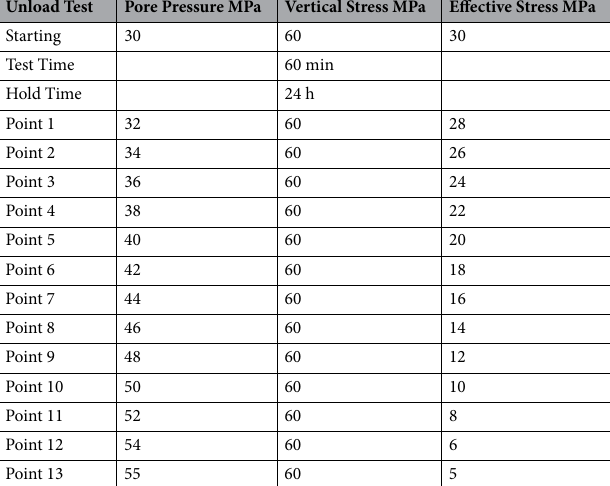
Table 2. Parameters of each experimental point in the unloading experiment.